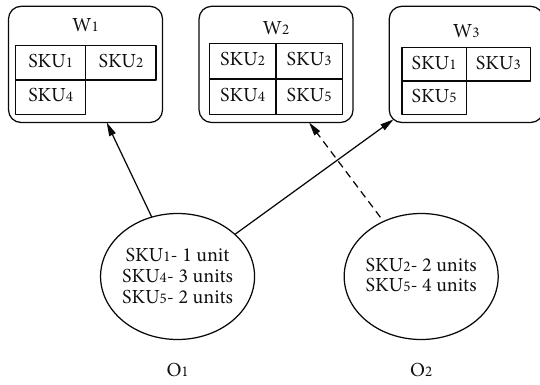
Figure 1: An illustrative example of orders split among di ff erent